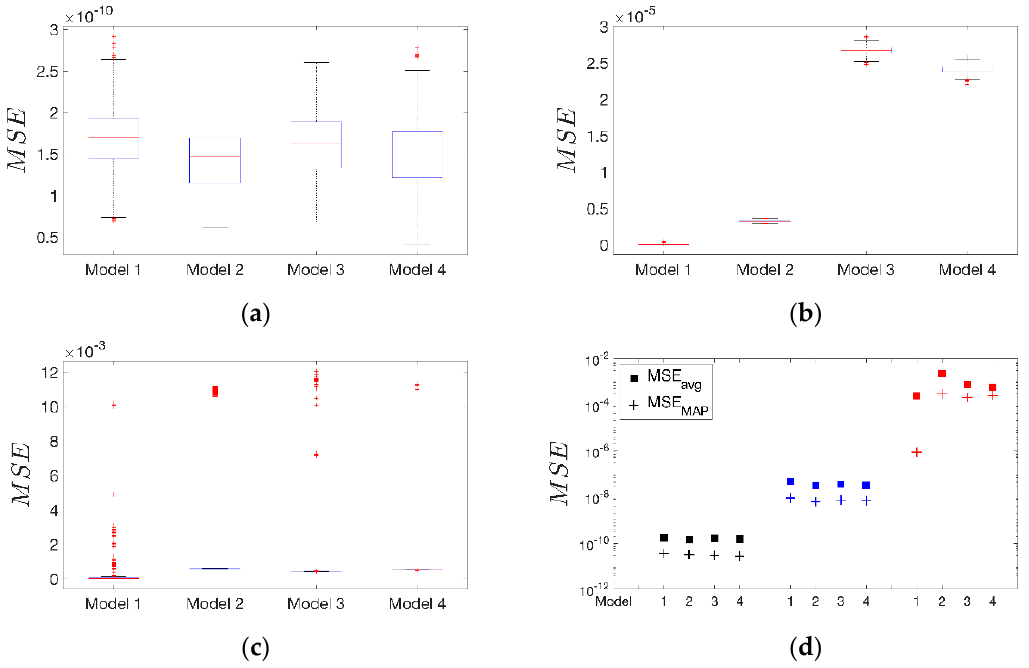
Figure 16. Boxplot representations (minimum, first quartile, median, third quartile and maximum) of the mean square error (MSE) computed on all the post-predictive models runs. Specifically: ( a ) boxplot of MSE for low level of degradation (PGA ≈ 1 m/s 2 ); ( b ) boxplot of MSE for medium level of degradation (PGA ≈ 6 m/s 2 ); ( c ) boxplot of MSE for high level of degradation (PGA ≈ 9 m/s 2 ). ( d ) Comparison between the average MSE computed over all the post-predictive model runs for each model (square markers), versus the MSE computed for the MAP estimate (cross markers). The comparison is differentiated into three colored subsets: (i) in black, MSEs computed for a low level of degradation (PGA ≈ 1 m/s 2 ); (ii) in blue, MSEs computed for a medium level of degradation (PGA ≈ 6 m/s 2 ); (iii) in red, MSEs computed for a high level of degradation (PGA ≈ 9 m/s 2 ).